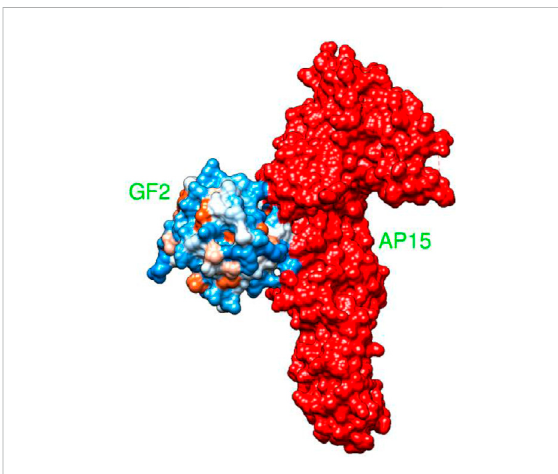
FIGURE 2 Docked conformation of an FGF2 receptor (shown by the hydrophobic receptor) with AP15 (shown by the red surface).